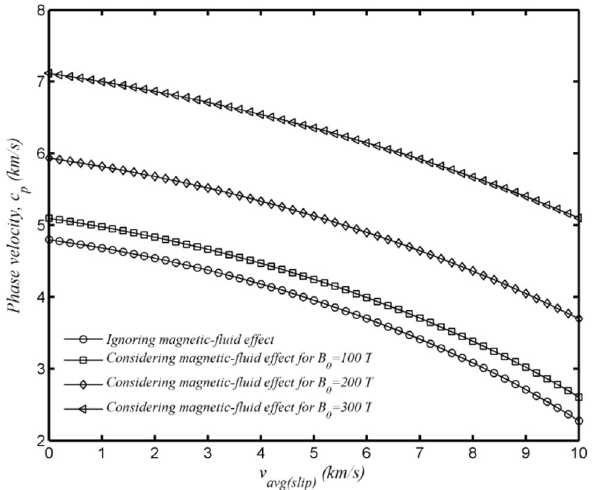
Fig. 8 The wave frequency versus the magnetic intensity for Kn = 0.001 , v = 1000 m ∕ s and k = 5 ( 1 ∕ nm ) avg ( slip )